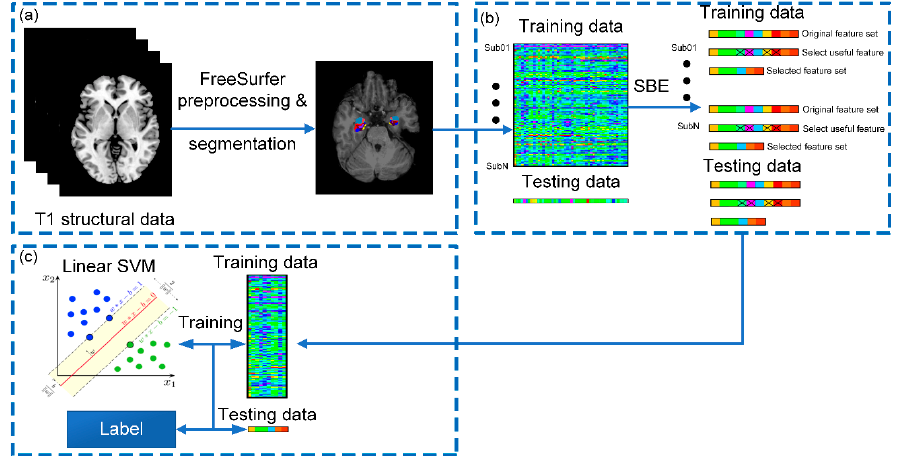
Figure 1. Schematic diagram of the proposed classification framework: ( a ) structural MRI (sMRI) preprocessing, hippocampal and amygdaloid subregion segmentation; ( b ) feature selection via sequential backward elimination (SBE) algorithm; and ( c ) classification using a linear support vector machine (SVM). Sub01~SubN represent all enrolled